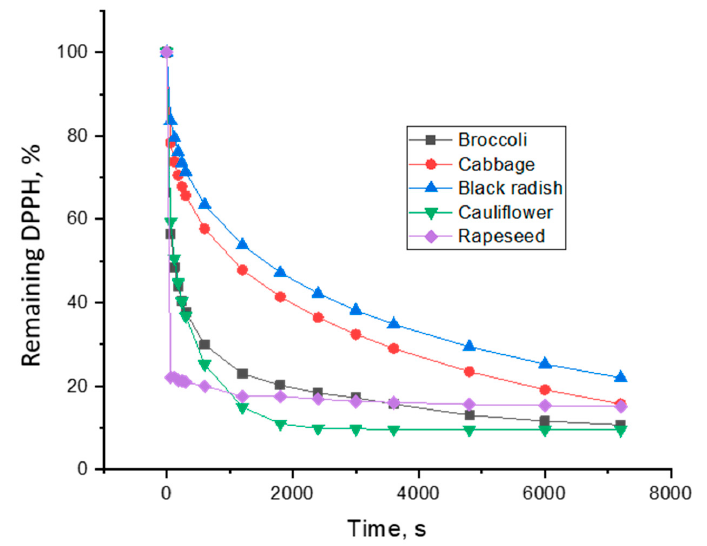
Figure 1. Antioxidant behavior of Brassicaceae extracts A.